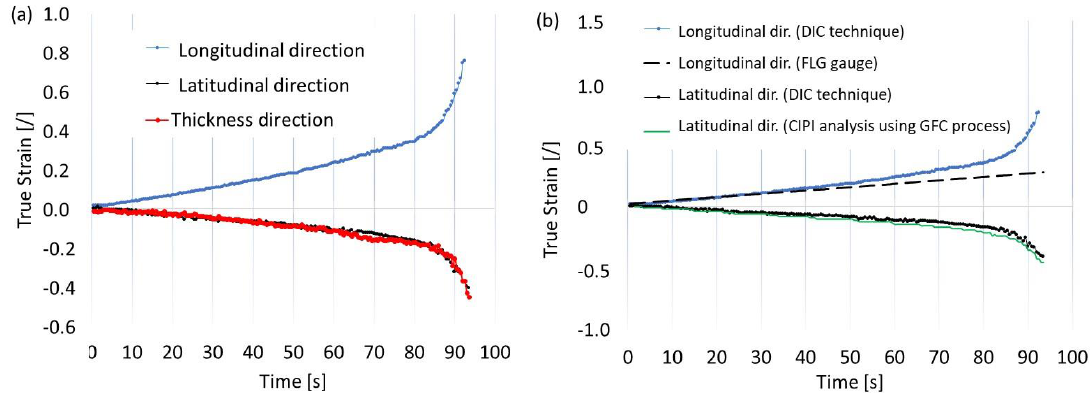
Figure 13. Characteristics of the DIC measurement: ( a ) final stage of tension, ( b ) true strain measurement in the longitudinal direction (distance AB), ( c ) true strain measurement in the latitudinal direction (distance CD).